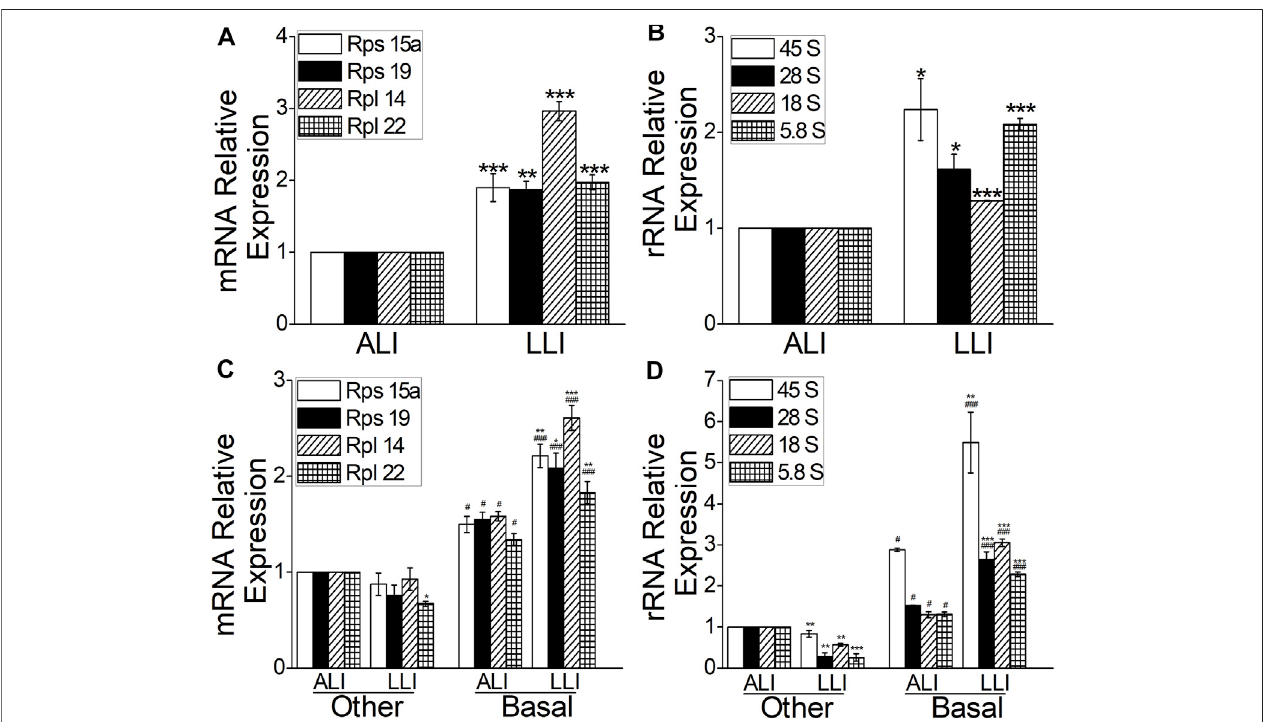
FIGURE 5 | Ribosome biogenesis was enhanced in the mode of the LLI culture. (A – B) Real-time PCR results of ribosome biogenesis – related RNAs (Rps15a, Rps19,Rpl14,andRpl22aswellas45,28,18,and5.8SrRNA).* p < .05,** p < .01,*** p < .001,comparedwithALIgroup, n (cid:1) 3.Student ’ s t -testwasusedtoanalyzethe differenceofthemeans. (C – D) Ribosomebiogenesis – related RNAsweresigni fi cantlyupregulatedinbasalcellsinthemodeofLLIculture.* p < .05,** p < .01,*** p < .001 compared with ALI group within same cell type, # p < .05, ### p < .001, compared with the other cells in corresponding group. n (cid:1) 3. One-way ANOVA followed by Bonferroni ’ s test was used to analyze the difference of the means for signi fi cance.